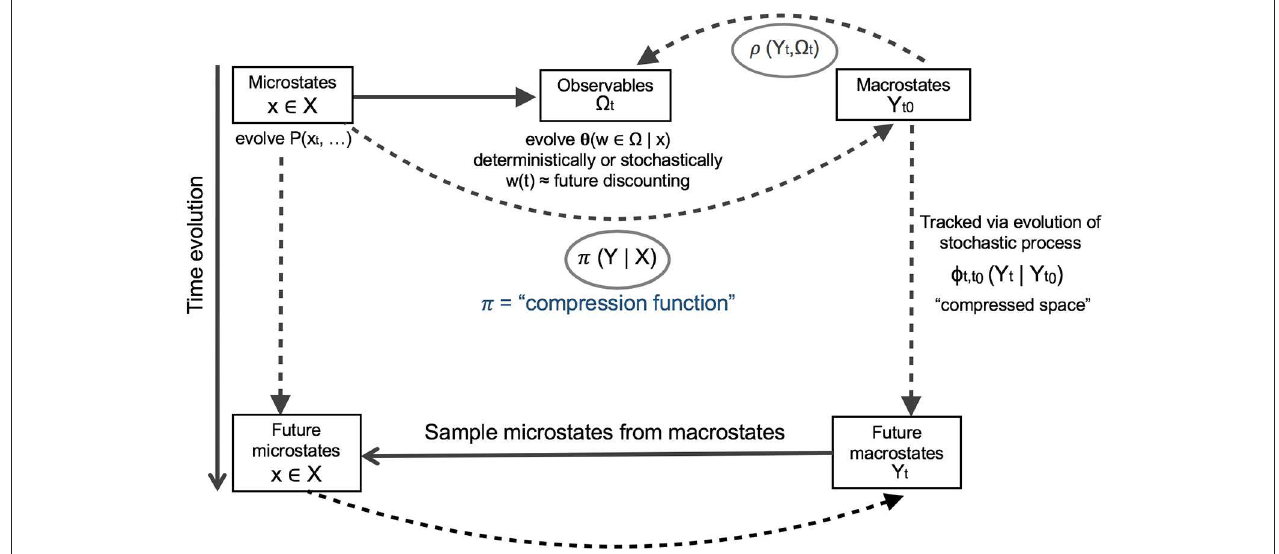
FIGURE 5 | A roadmap for a rigorous approach to coarse-graining in complex systems, from Wolpert et al. (2017). The key to optimized coarse-graining is a “compression function,” here designated as π (Y|X), which translates microstates (fine-scale information X) into macrostates (broad-scale or “landscape scale” information Y). To ensure that the choice of compression function is optimal, we model the time evolution of the macrostates identified by π (Y|X) in parallel with evolution of the original microstates. Some combination of π (Y|X), the computed macrostates of the system “Y,” the time evolution of macrostates by a stochastic process ϕ , and the mapping of macrostates onto observables by some empirical relationship ρ will be optimized by a multivariate objective function. Our focus here is on π (Y|X), to address the coarse-graining challenge, for which some choices include simple adding up, regression, simulation, and maximization of information